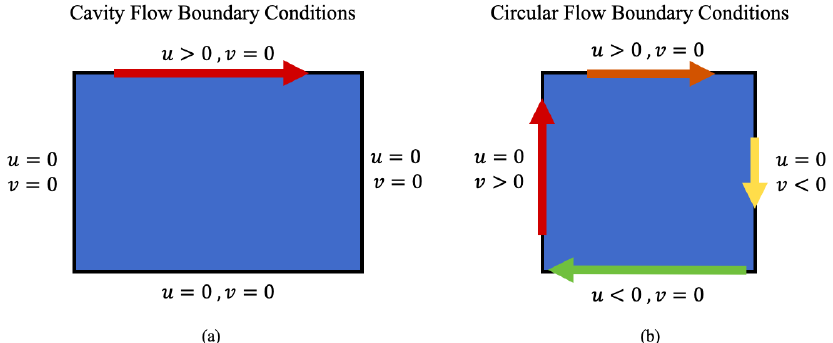
Figure 1. Boundary conditions are depicted pertaining to ( a ) cavity flow and ( b ) circular flow for the projection methods